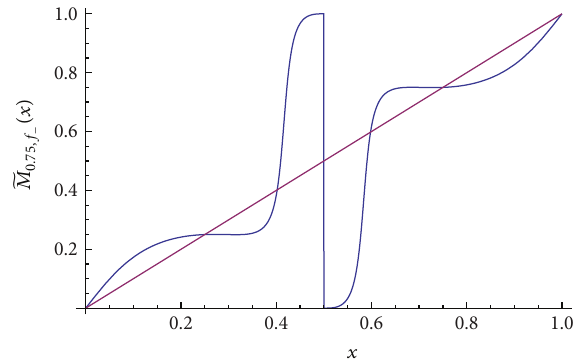
̃𝑀 𝜆 = 0.75 , where the BZ interval is 𝜆,𝑓 − with